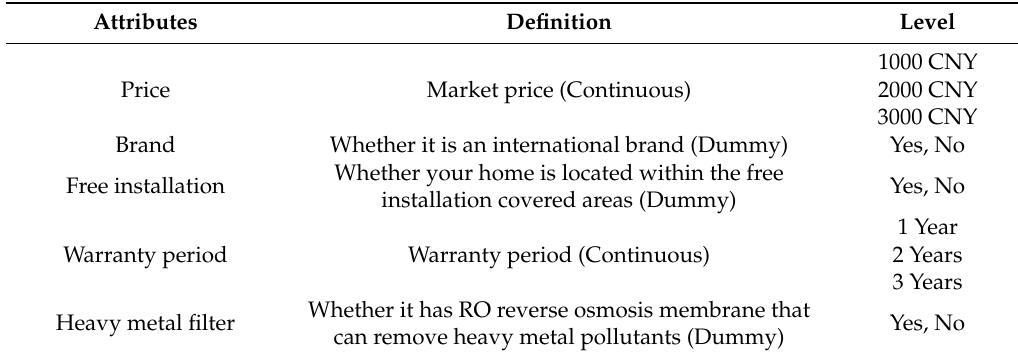
Table 1. Attributes and levels of a water purifier.